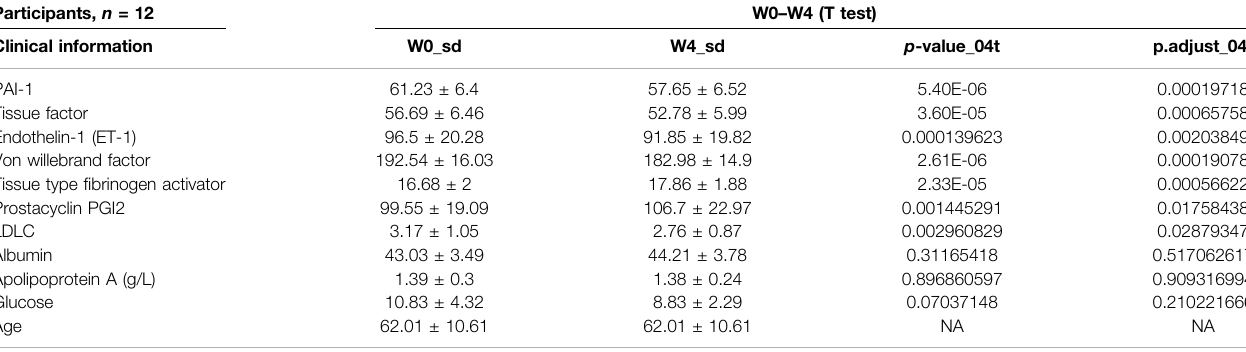
TABLE 1 | Clinical information for patients treated with GLP-1 from W0 toW4.